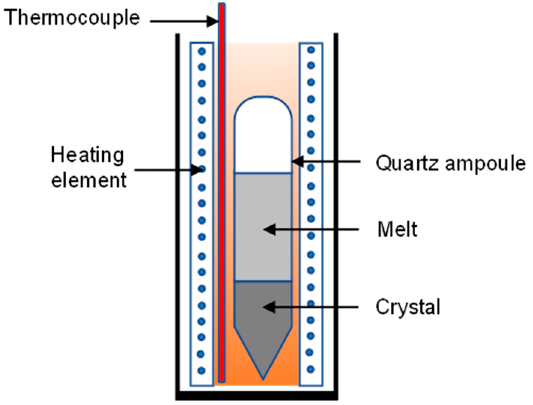
Figure 4. A schematic of a temperature gradient vertical furnace used in the temperature gradient growth method.